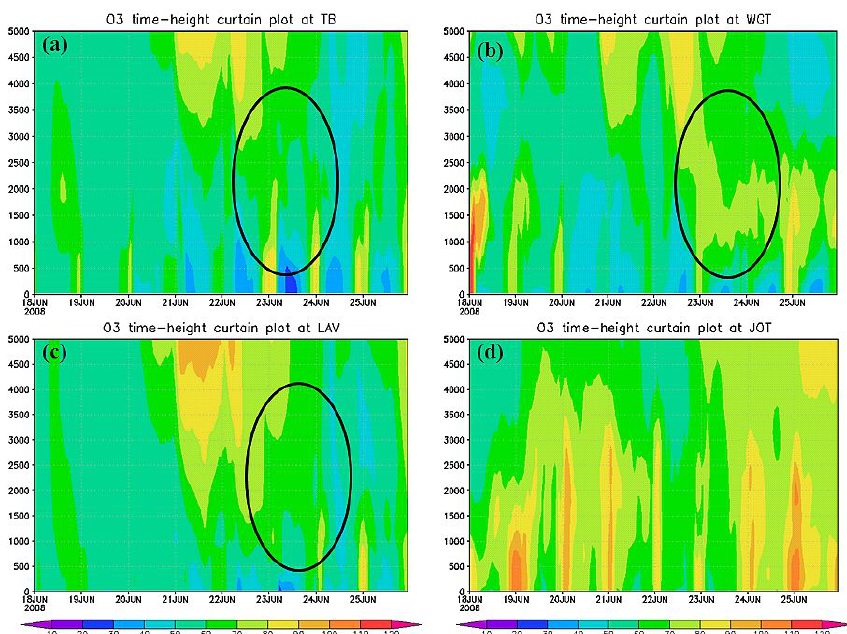
Fig. 7. O 3 time-height (a.g.l., m) curtain plots from the 12km base case across sites at (a) TB (b) WGT (c) LAV and (d) JOT. Their elevations are 572m, 0m, 1756m and 20m, respectively.